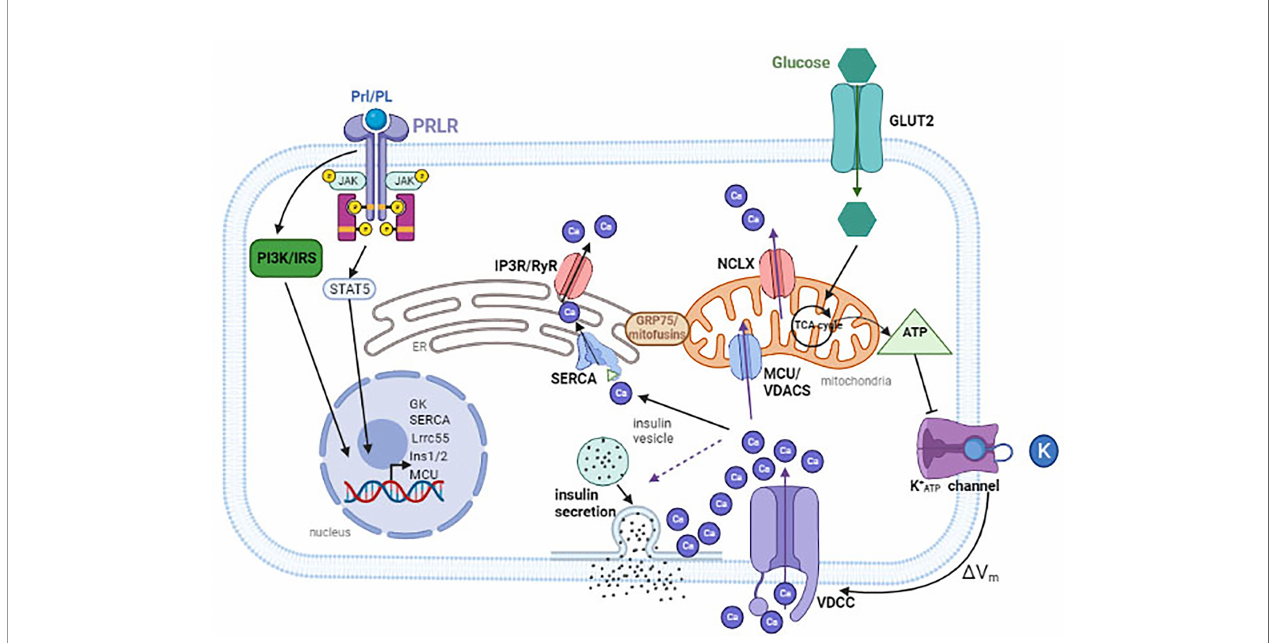
FIGURE 1 | Glucose is transported into the cytoplasm through glucose transporters (GLUT2 in rodents). Once inside, glucose are metabolized in the mitochondria to generate ATP. An increase in ATP to ADP ratio will cause the closure of ATP-sensitive potassium channel (K ATP ), resulting in membrane depolarization. This leads to the opening of the L-type voltage-dependent Ca 2+ channels (VDCC) and an in fl ux of Ca 2+ . To maintain [Ca 2+ ] m , Ca 2+ enters through the MCU or the VDACs and escapes through the NCLX. Ca 2+ is pumped into the ER through ATP-dependent SERCA, and is released back into the cytosol through the IP3R or RyR calcium channels. Calcium can also fl ow from the ER to the mitochondria. During pregnancy, placental hormones bind to PrlR, inducing a signal cascade that results in up regulation of several genes to increase insulin production and secretion. These include Lrrc55 and SERCA to maintain [Ca 2+ ] ER , MCU to maintain [Ca 2+ ] m , and INS1/2 to increase insulin expression. VDAC, voltage-dependent anion channels; MCU, mitochondrial Ca 2+ uniporter; PRLR, prolactin receptor; Prl/PL, prolactin/placental lactogen. The dashed line arrow indicates that in fl ux of calcium induces insulin secretion. Created with